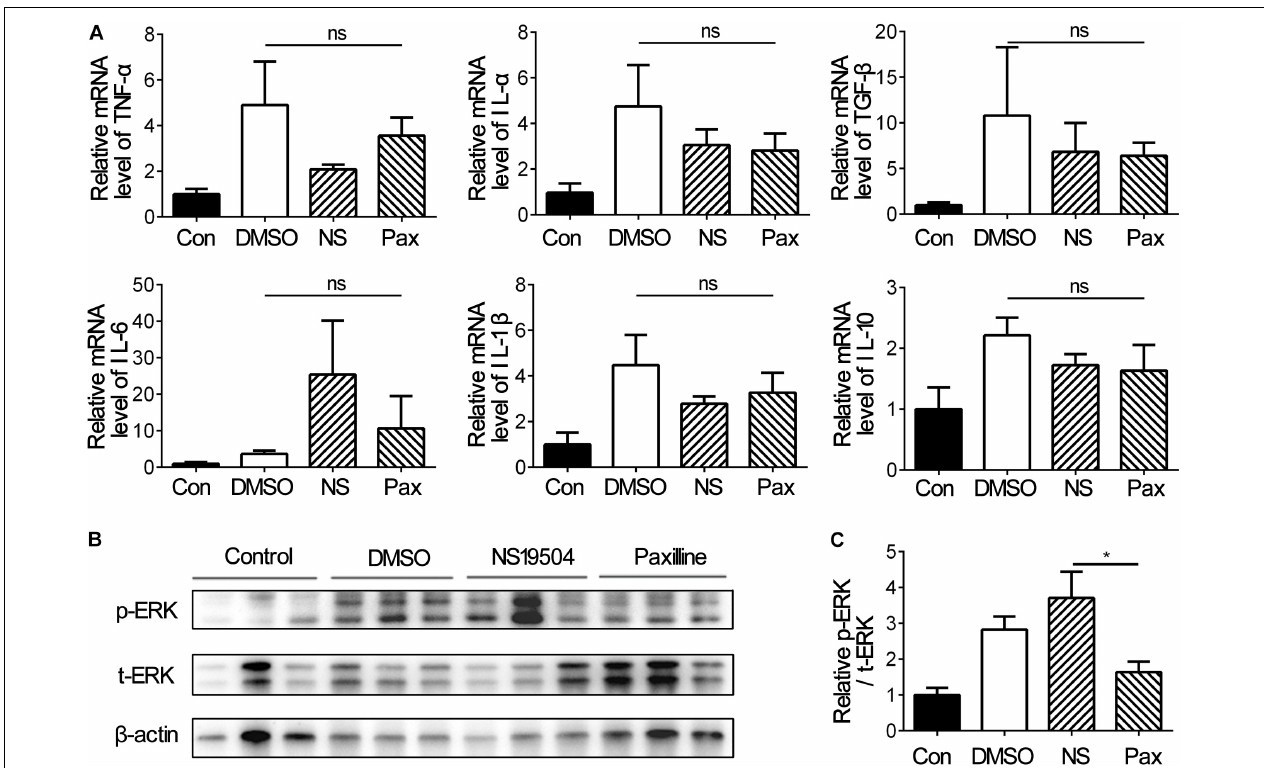
FIGURE 6 | Inflammatory factors and phosphorylated-ERK expressions under different treatments at 3 days after tMCAO . (A) Bar graph represents the relative mRNA levels of inflammatory factors including TNF- α , TGF- β , IL-10, IL-6, IL-1 β , and IL-1 α . Data are mean + SE, n = 3 per group. (B) Representative image of Western blot of phosphorylated-ERK1/2 (p-ERK), total-ERK1/2 (t-ERK), and β -actin at 3 days after tMCAO. (C) Bar graph showing the relative protein levels of p -ERK vs. t-ERK at 3 day after tMCAO. Data are mean + SE, n = 9 per group. *NS19504 vs. Paxilline group, * p < 0.05; ns, no